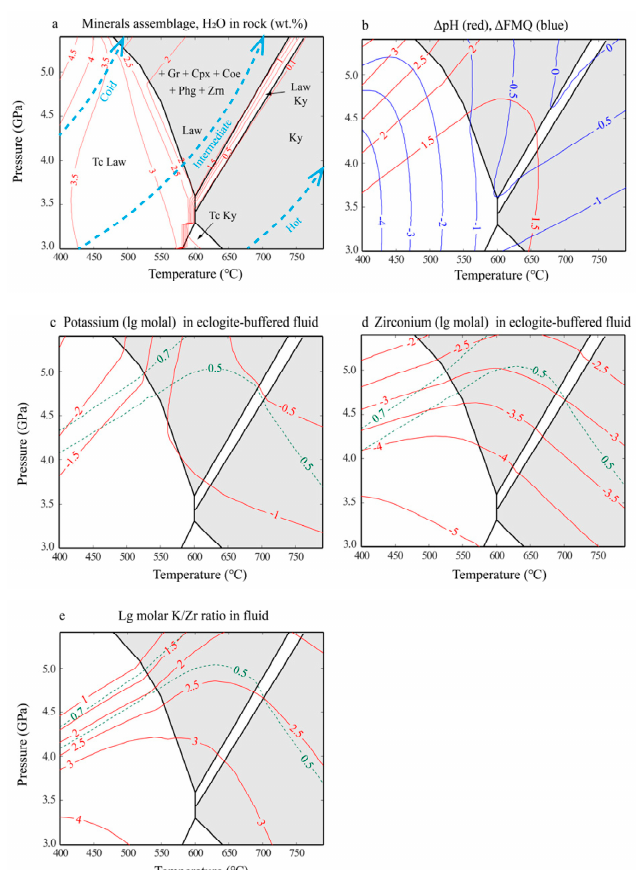
Figure A1. Thermodynamic simulation results of fluid-eclogite equilibrium using fluid with 2 wt.% of dissolved NaCl, showing the mineral assemblage and water content of eclogite ( a ), the Δ pH and Δ FMQ ( b ) and the solubilities of K ( c ) and Zr ( d ) in the eclogite-buffered fluids, as well as the logarithm of molar ratio between fluid K and Zr ( e ). The contours of ionic strength equal to 0.5 and 0.7 are shown as green dashed lines.